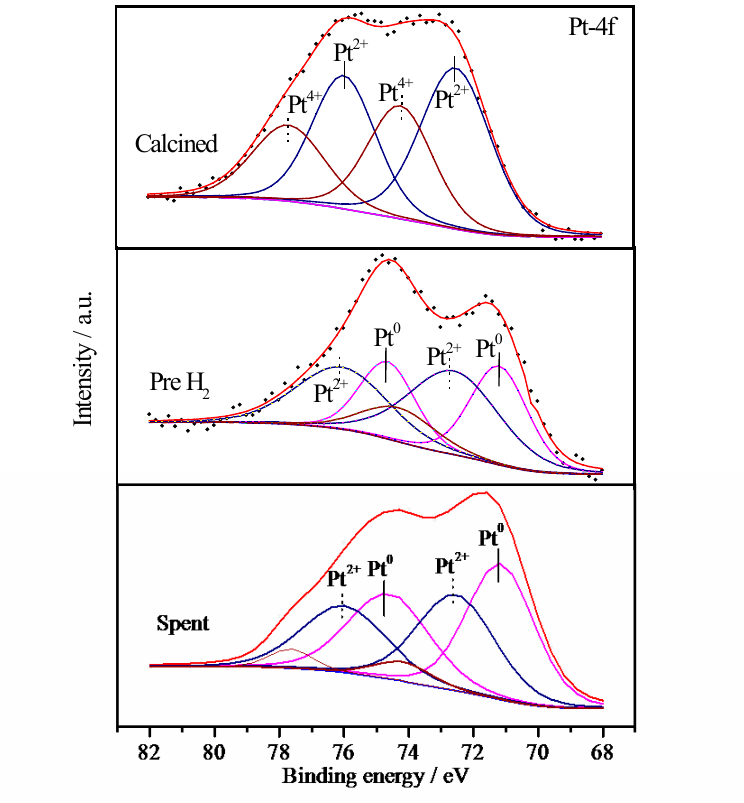
Figure 12. Pt-4f XPS spectra of the calcined, reduced, and spent Pt/CoO x /SiO 2 . Table 4. The relative proportions (peak areas) of different Pt species as observed from the Pt-4f/Pt-4d XPS spectra of the calcined (I), H 2 pretreated (II) and spent (III) Pt/CoO x /SiO 2 , Pt/CoO x /TiO 2 , Pt/CoO x /Al 2 O 3 . Relative Proportions Sample Treatment State